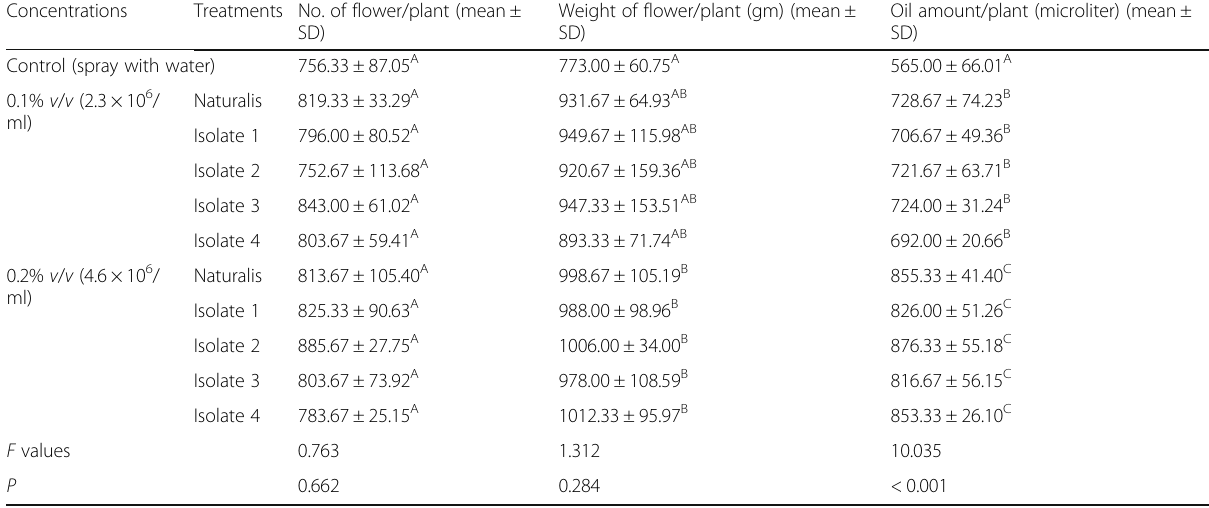
Means within each column bearing different letters are significantly different according to the Duncan test ( P